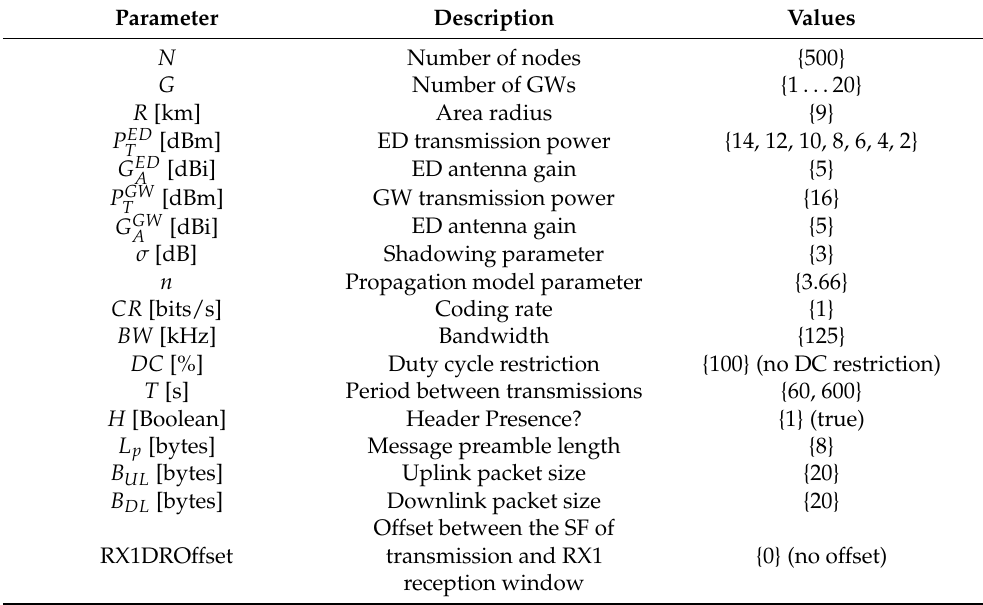
Table 2. Input parameters for the chosen